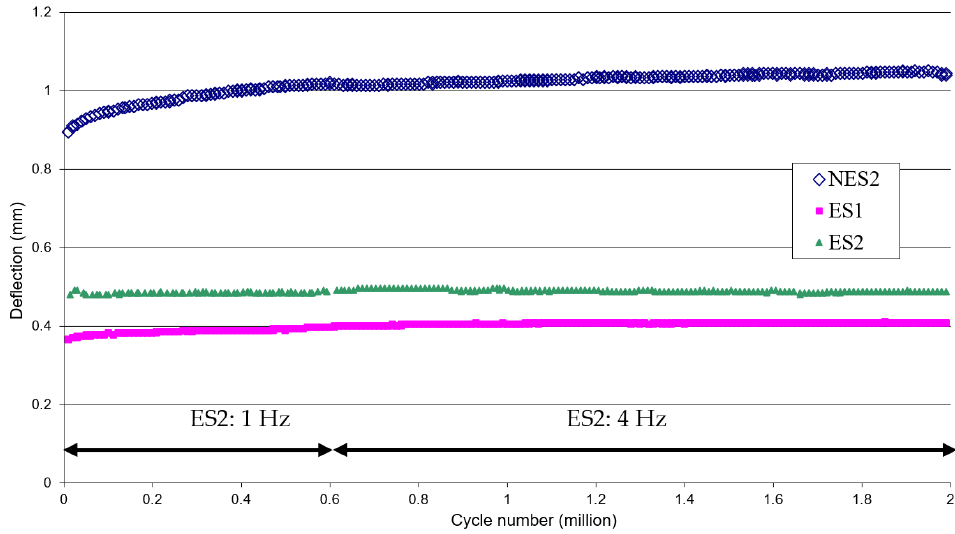
Figure 13. Evolution of maximum deflection during fatigue tests of NES2, ES1 and ES2.